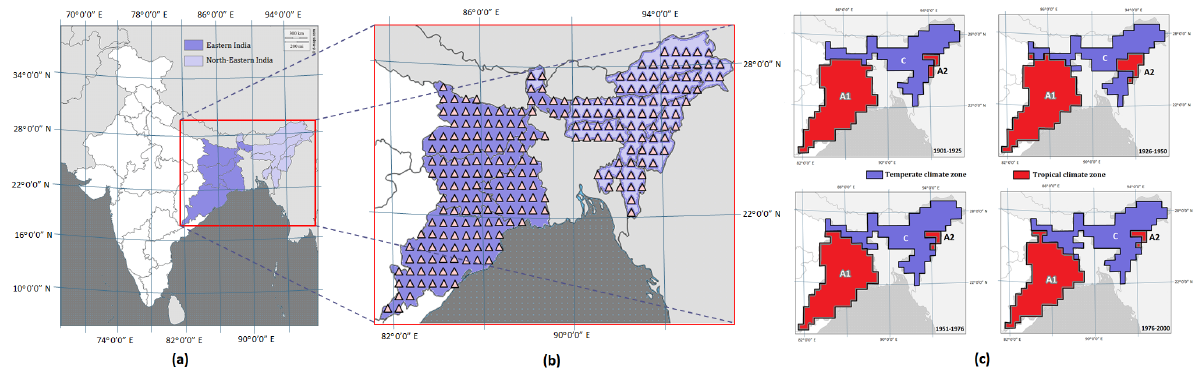
Figure 4. Study area: (a) Eastern and North-Eastern region of India, (b) 240 locations on a 0 . 5 ◦ × 0 . 5 ◦ grid , (c) Identified climate zones in the study region